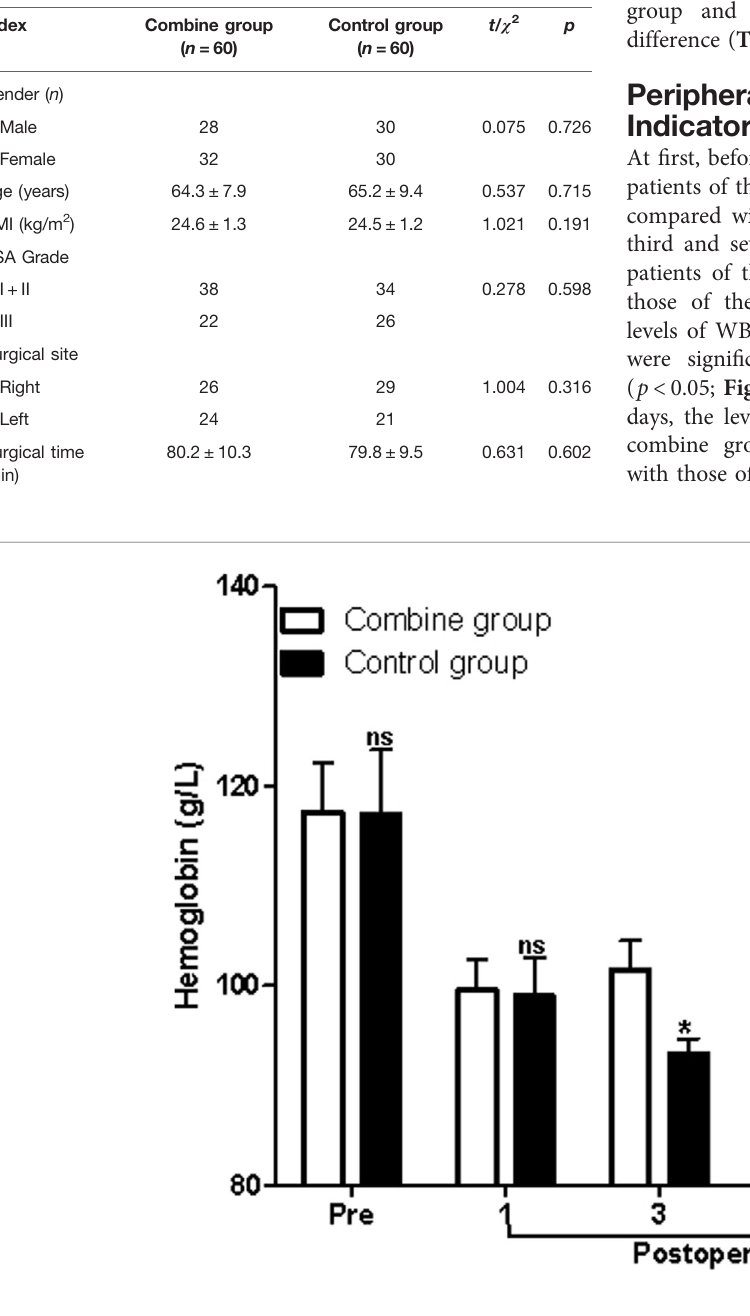
FIGURE 1 | Comparison of hemoglobin at different times in patients of two groups. Note: Compared with the combine group, ns p >0.05 and * p